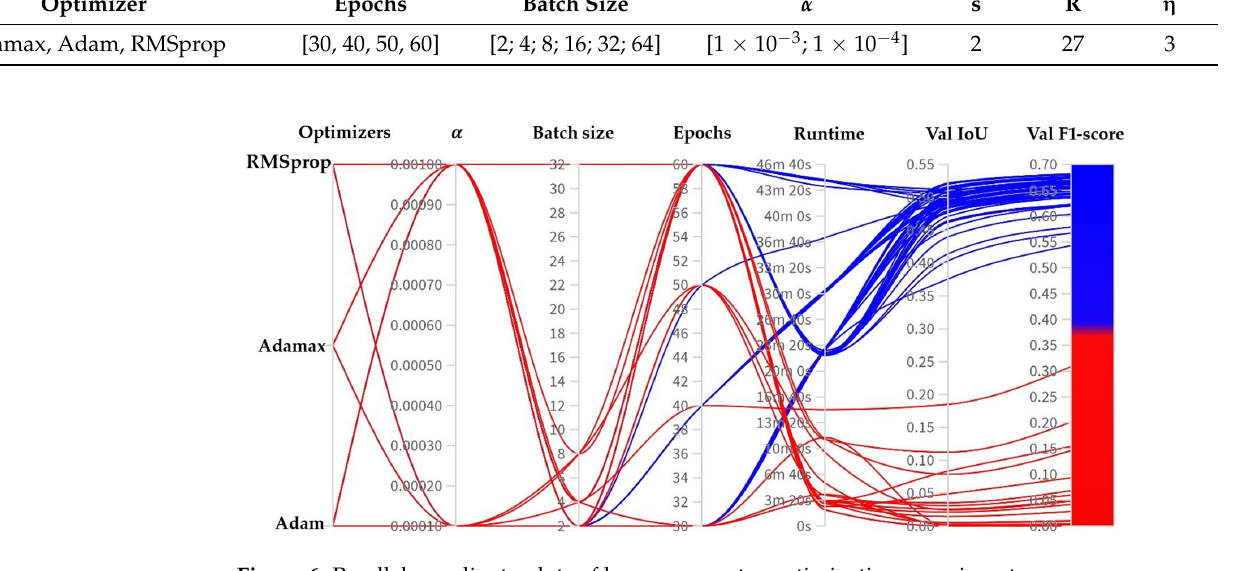
Table 3. Hyperparameter reduced search space .